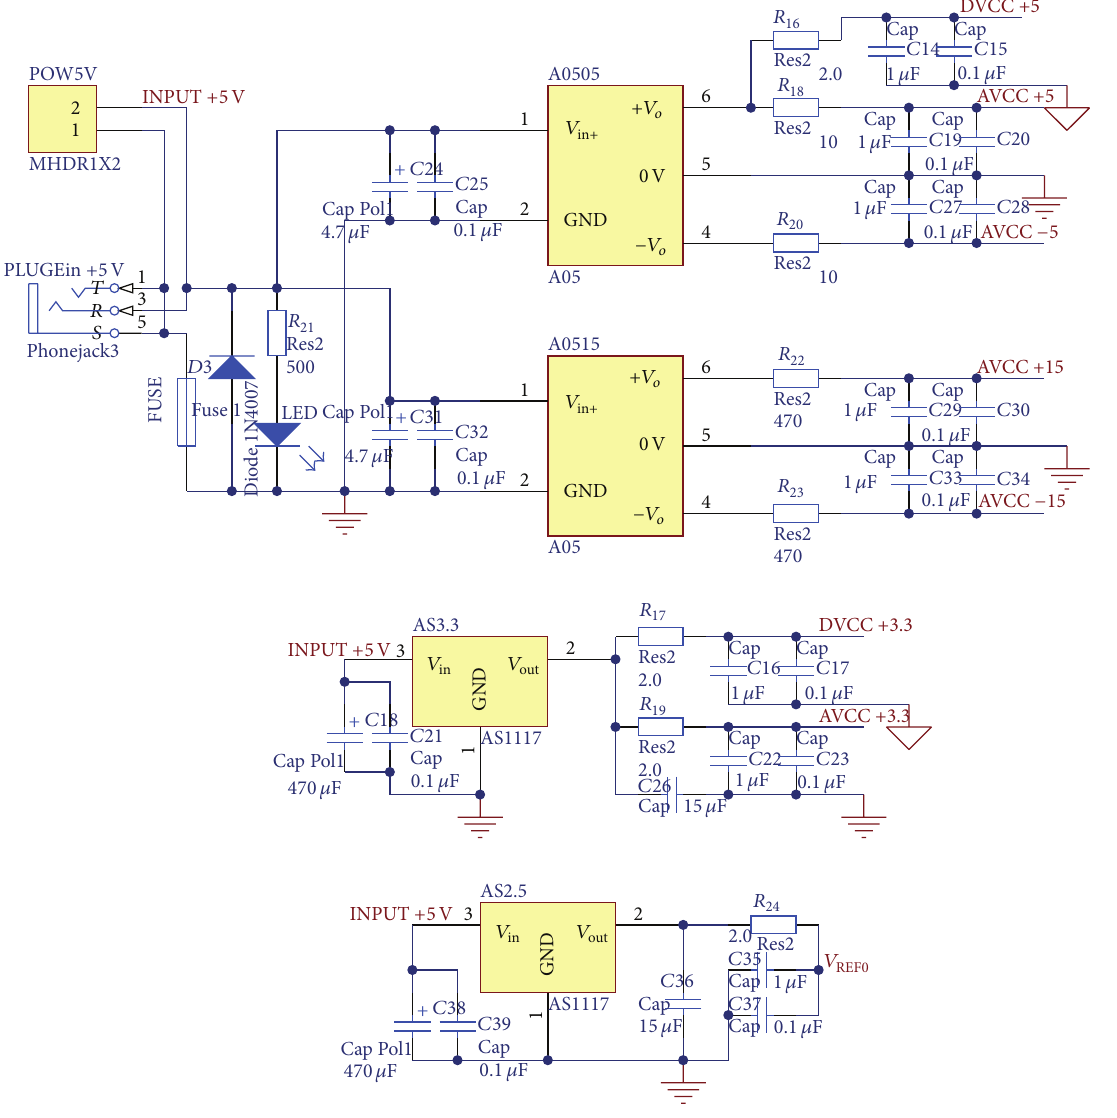
Figure 3: Circuit of the power